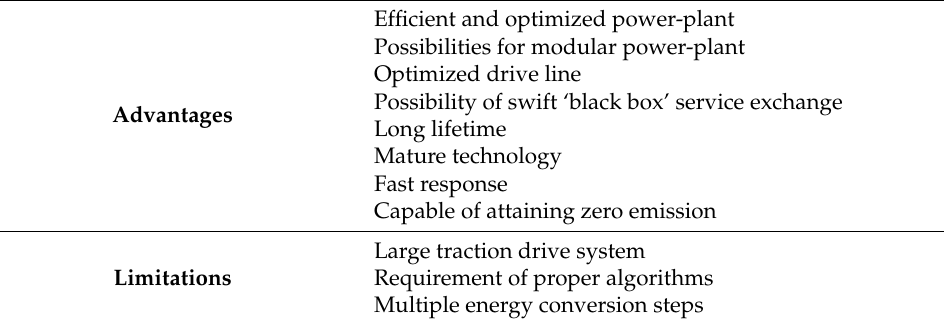
Table 2. Advantages and limitations of series hybrid configuration. Adapted from